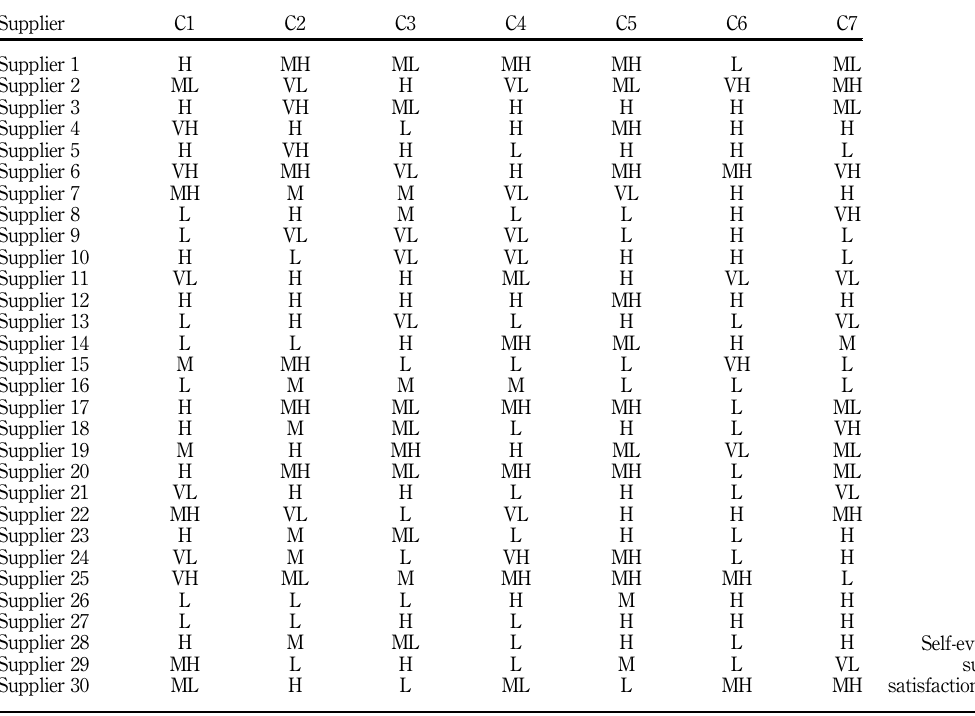
Table VI. Self-evaluation